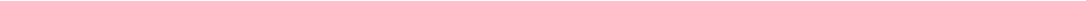
Figure 1: Illustration of time trends for the prescription of different immunosuppressive (IS) regimens in normal-risk renal transplant (TX) recip- ients between 2008 and 2017.“TAC-based” was defined as the combination of prednisone, tacrolimus and mycophenolate mofetil. “CsA- based” corresponds to the combination of ciclosporin, prednisone and mycophenolate mofetil. “mTOR-based” corresponds to the combination of any calcineurin inhibitor, everolimus and prednisone, with or without mycophenolate mofetil. All other immunosuppressive drug combina- tions and therapies were summarised as “Other” immunosuppression.